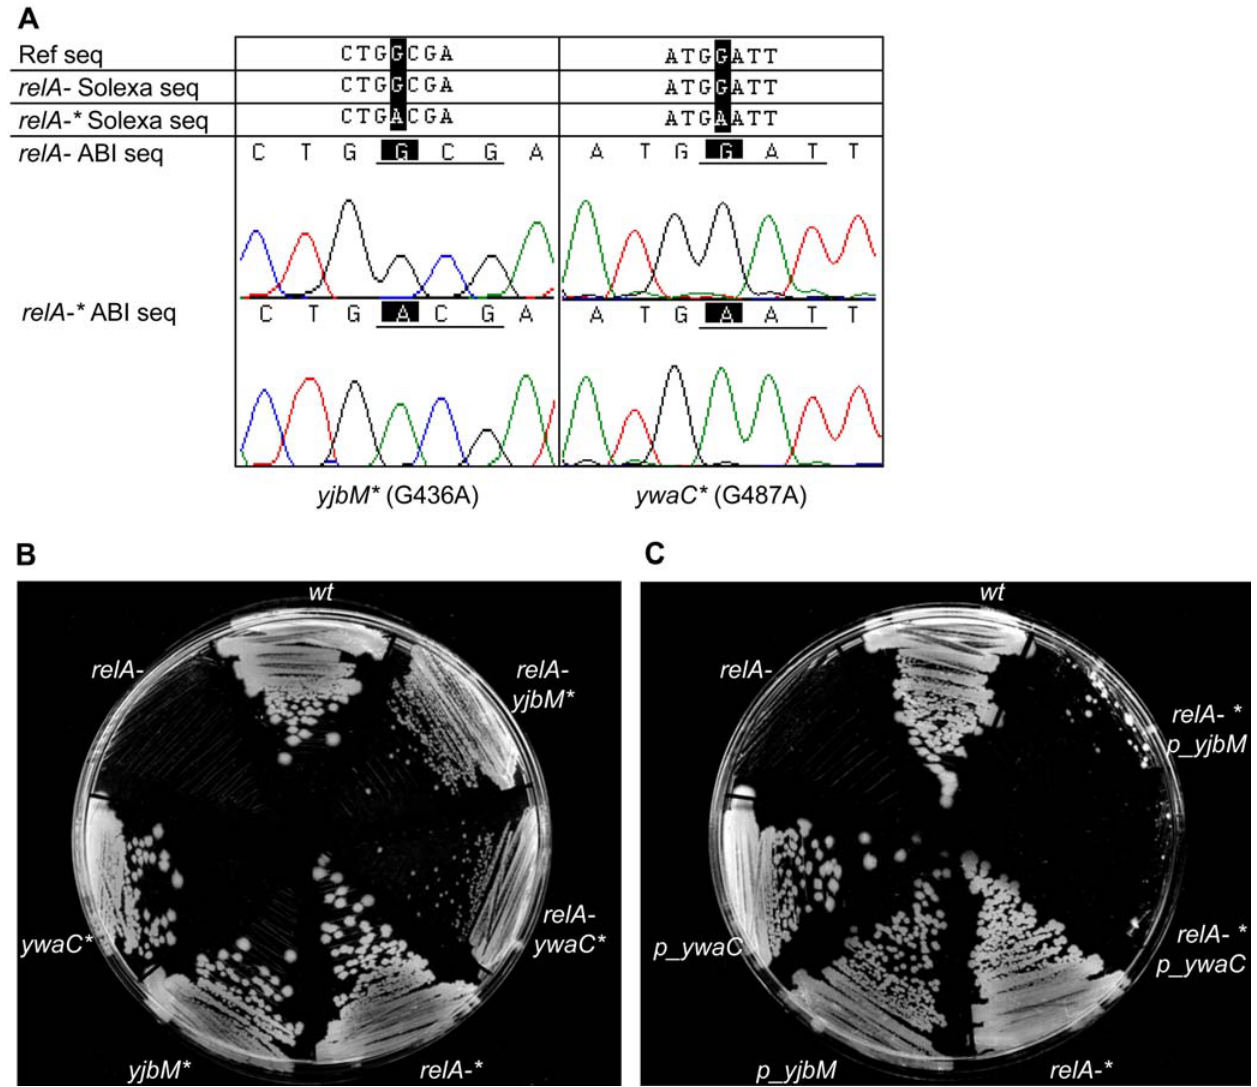
Figure 6. yjbM and ywaC genetically interact with relA . A) Verification of the Solexa-identified yjbM* and ywaC* mutations by Sanger sequencing. The reference sequence for yjbM or ywaC is shown first, followed by the Solexa results for these genes in the strain relA- , in which the relA gene is deleted, and the strain relA-* which has the identical relA deletion as well as second site suppressor mutations. Chromatograms of the Sanger sequencing results for each gene are shown last. B) Partial suppression of the relA - growth defect by introduction of either the yjbM* or ywaC* allele from relA -*. The strains shown in clockwise order are: i) JH642 (wt), ii) relA- with the yjbM* mutation from relA-* ( relA-yjbM* ), iii) relA- with the ywaC* mutation from relA-* ( relA- ywaC* ), iv) relA- with both suppressor mutations yjbM* and ywaC* ( relA-* ), v) yjbM* (in the JH642 background), vi) ywaC* (in the JH642 background) and vii) relA- (in the JH642 background, with no suppressors). The strains were plated on LB. relA- has a significant growth defect, which is partially relieved by introduction of either yjbM* or ywaC* , and is fully rescued by both mutations together. C) Re-introduction of a growth defect in the relA-* suppressor strain by expression of either yjbM or ywaC . The strains shown in clockwise order are: i) JH642 (wt), ii) relA-* , with suppressor mutations in both yjbM and ywaC , expressing wild type yjbM ( relA- p_yjbM ), iii) relA-* expressing wild type ywaC ( relA-* p_ywaC ), iv) relA- with suppressor mutations in yjbM and ywaC ( relA-* ), v) JH642 with ectopic expression of wild type yjbM ( p_yjbM ), vi) JH642 with ectopic expression of wild type ywaC ( p_ywaC ), and vii) relA- (in the JH642 background, with no suppressors). Full length wild type yjbM and ywaC were expressed from the IPTG-inducible pHyperSpac promoter and strains were plated on LB-IPTG. Expression of either yjbM or ywaC abolishes the effect of the suppressors in relA-* , and introduces a significant growth defect that is comparable to relA-